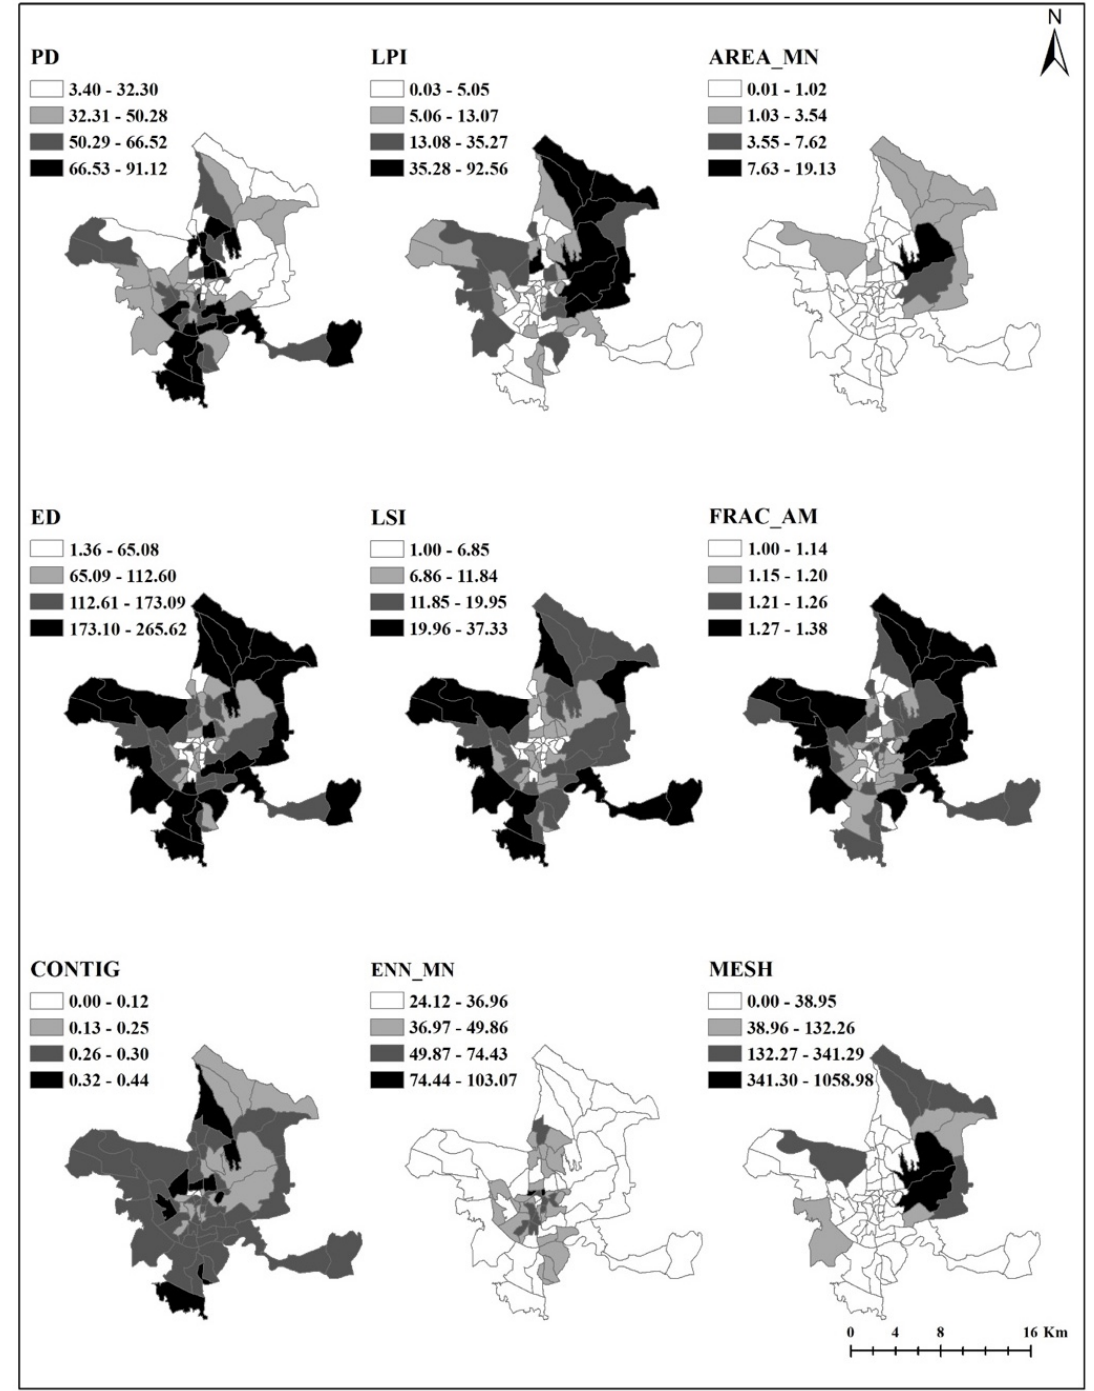
Figure 3. Spatial variation in landscape metrics by wards in Srinagar.